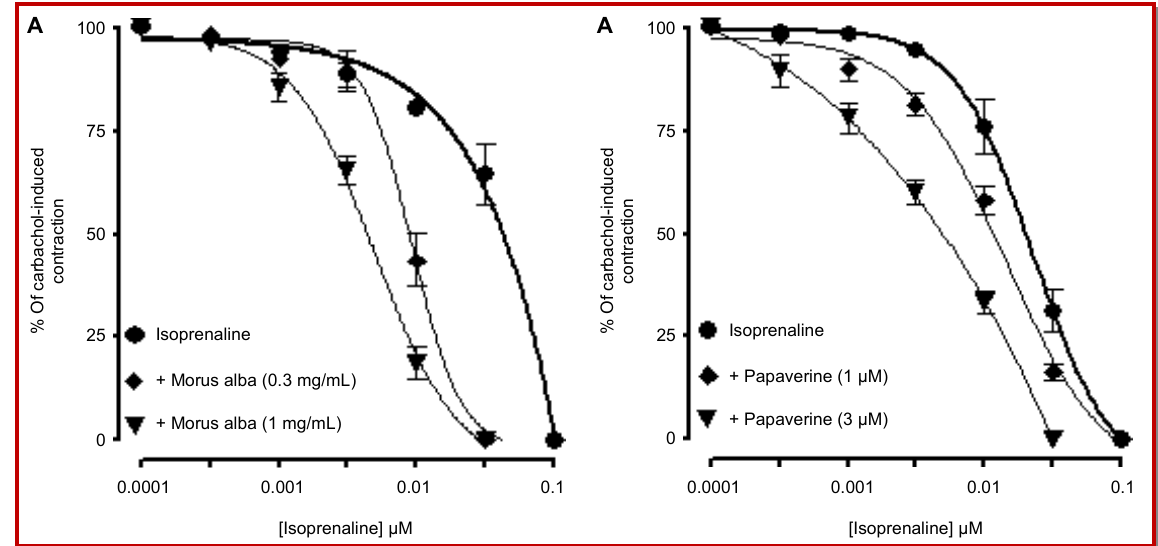
Figure 5: Inhibitory concentration-response curves of isoprenaline against carbachol-induced contractions in the absence and pres- ence of different concentrations of (A) crude extract of Morus alba and (B) papaverine in isolated guinea-pig tracheal preparations. Values shown are mean ± SEM, n =